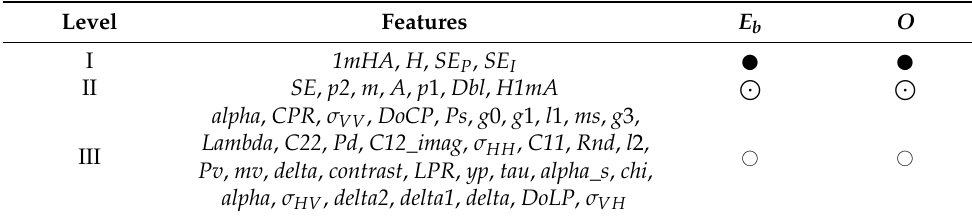
Table 4. Visualization of “black” eddies with CP